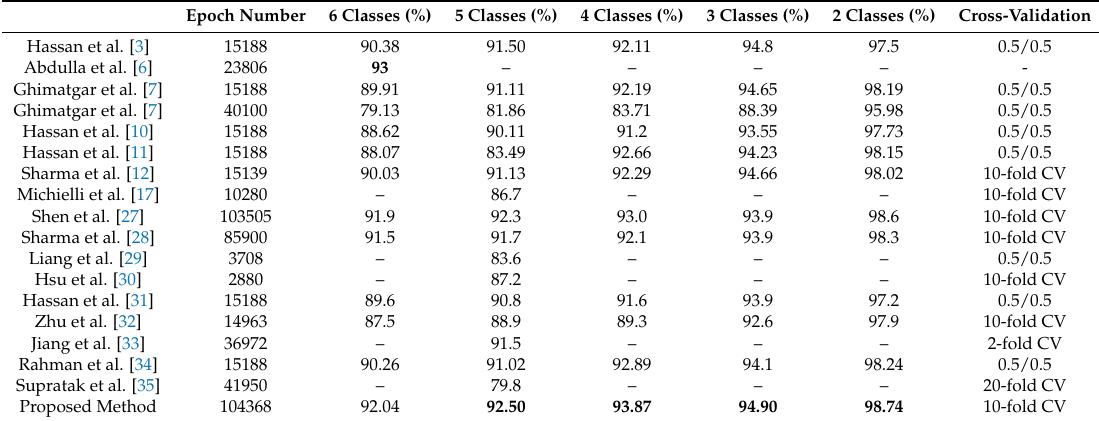
Table 32. The accuracy comparison of various published methods on the S-EDF database under the R&K standard. Highest accuracy in each case is highlighted in